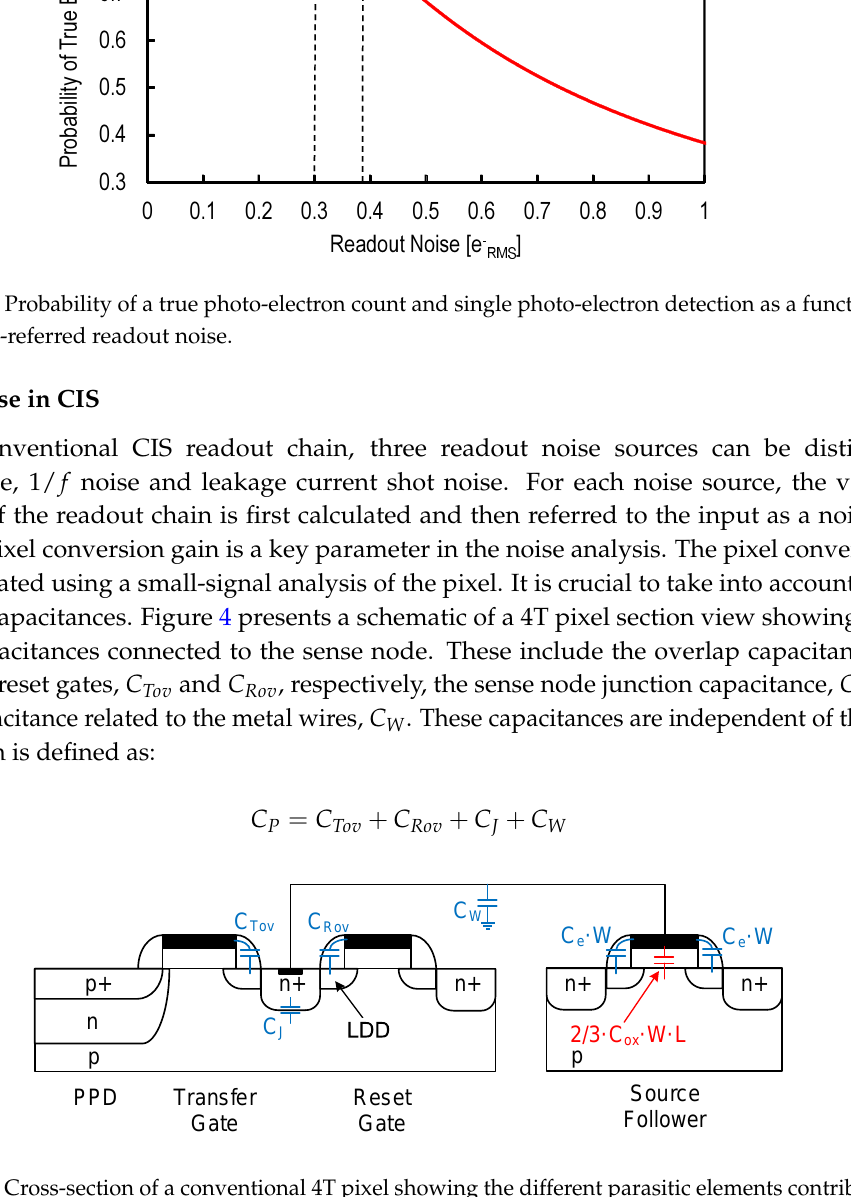
Figure 4. Cross-section of a conventional 4T pixel showing the different parasitic elements contributing to the sense node